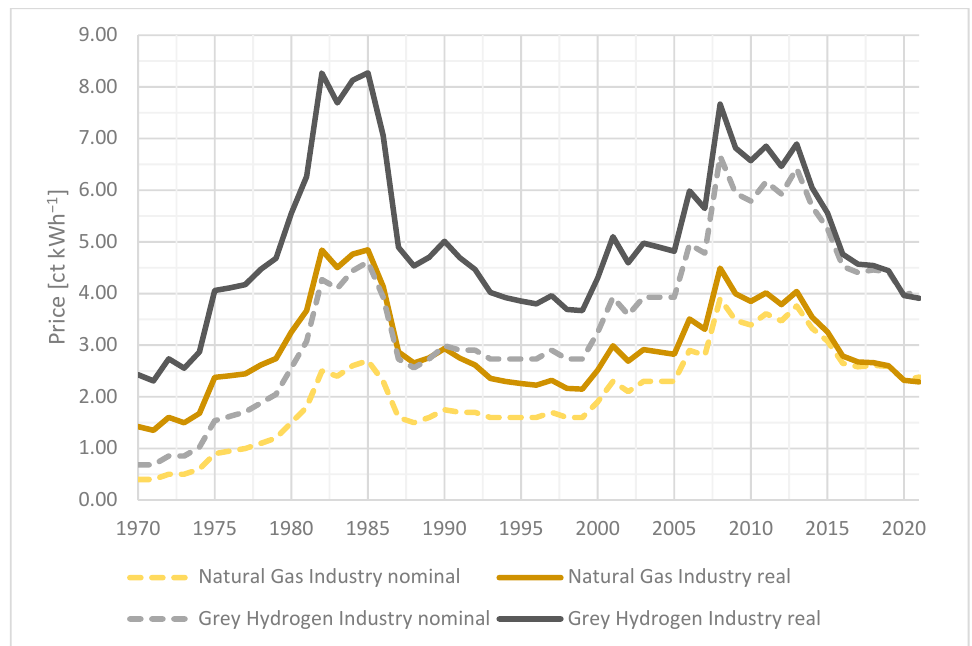
Figure 5. Development of nominal and real (ct 2020 ) natural gas and grey hydrogen prices for industry customers from 1970 to 2020 [48,49]. Prices for grey hydrogen are based on own calculations.